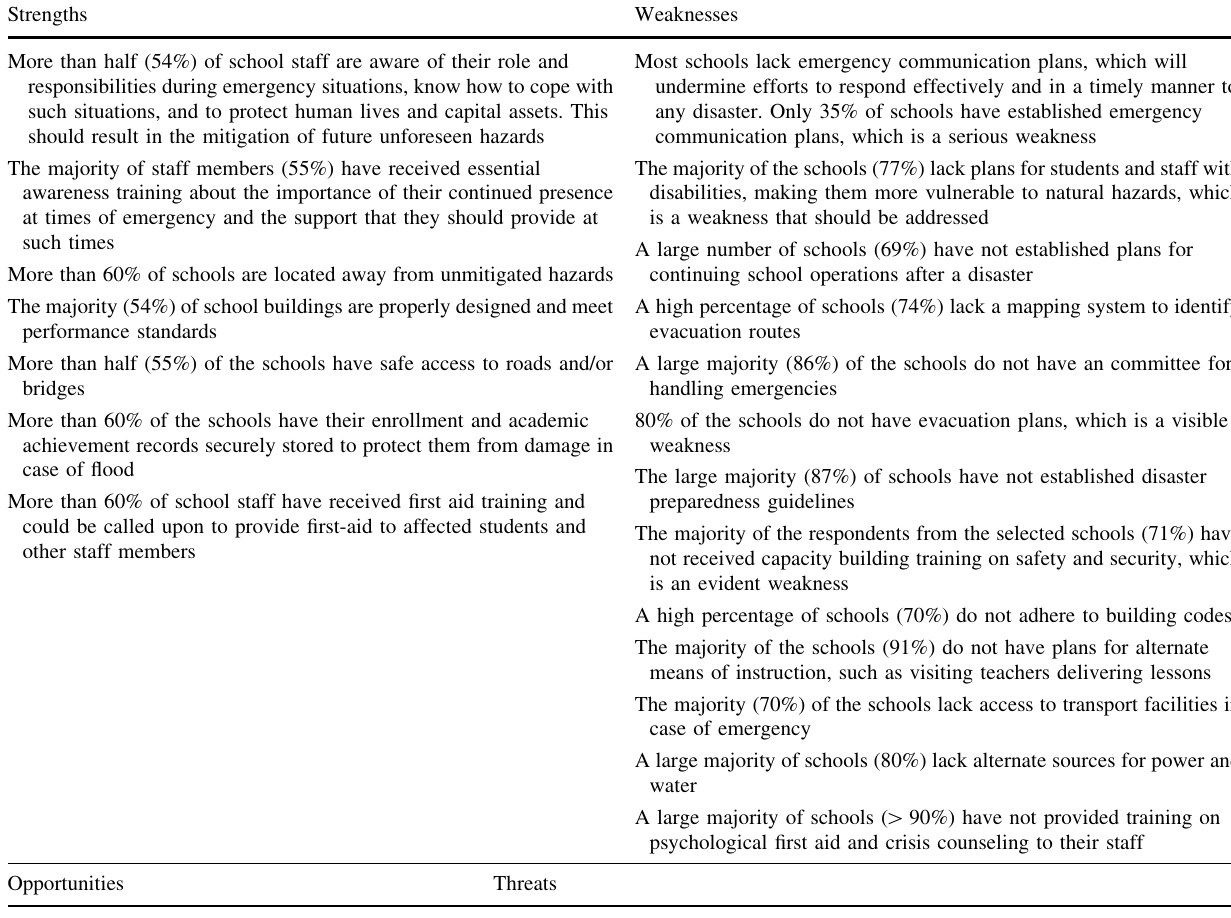
Table 1 SWOT analysis of the strengths, weaknesses, opportunities, and threats faced by schools in Khyber Pakhtunkhwa, Pakistan Strengths